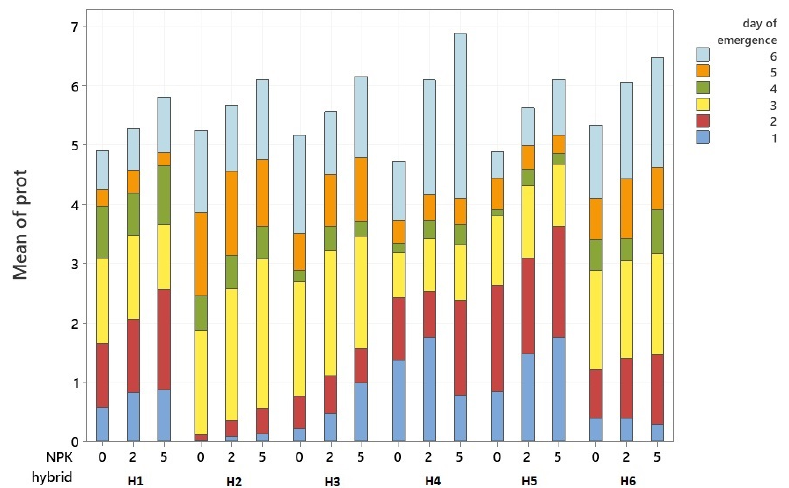
Figure 7. Interaction between hybrids, fertilizer, and day of emergence on protein content.